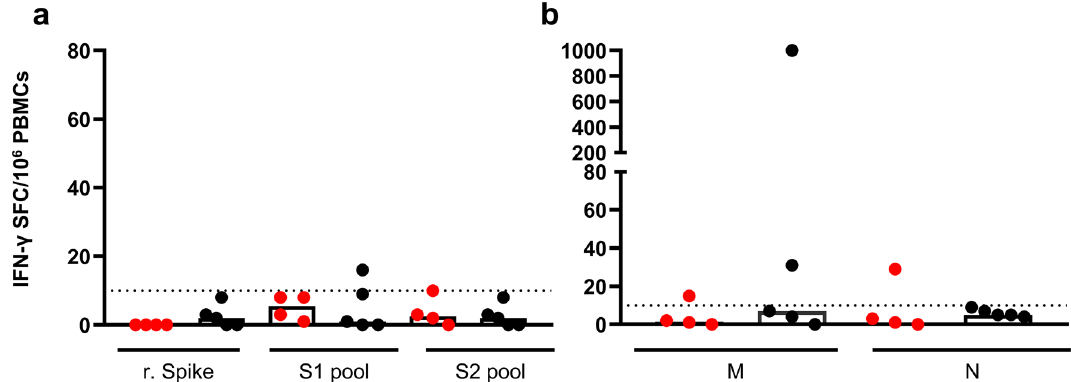
Figure 4. SARS-CoV-2 S, M and N protein cross-reactive T cells in non-responders. PBMCs from 4 young (red dot) and 5 older (black dot) adults NR, were cultured in the presence of ( a ) SARS-CoV-2 recombinant Spike protein (2.5 µg/ml) or S1 and S2 peptide pools (1 µg/ml); ( b ) N and M peptide pools (1 µg/ml each peptide) and frequency of IFN-γ producing T cells measured by ELISpot. Data were background subtracted and expressed as SFC/10 6 PBMCs. Each dot represents a single subject and columns the